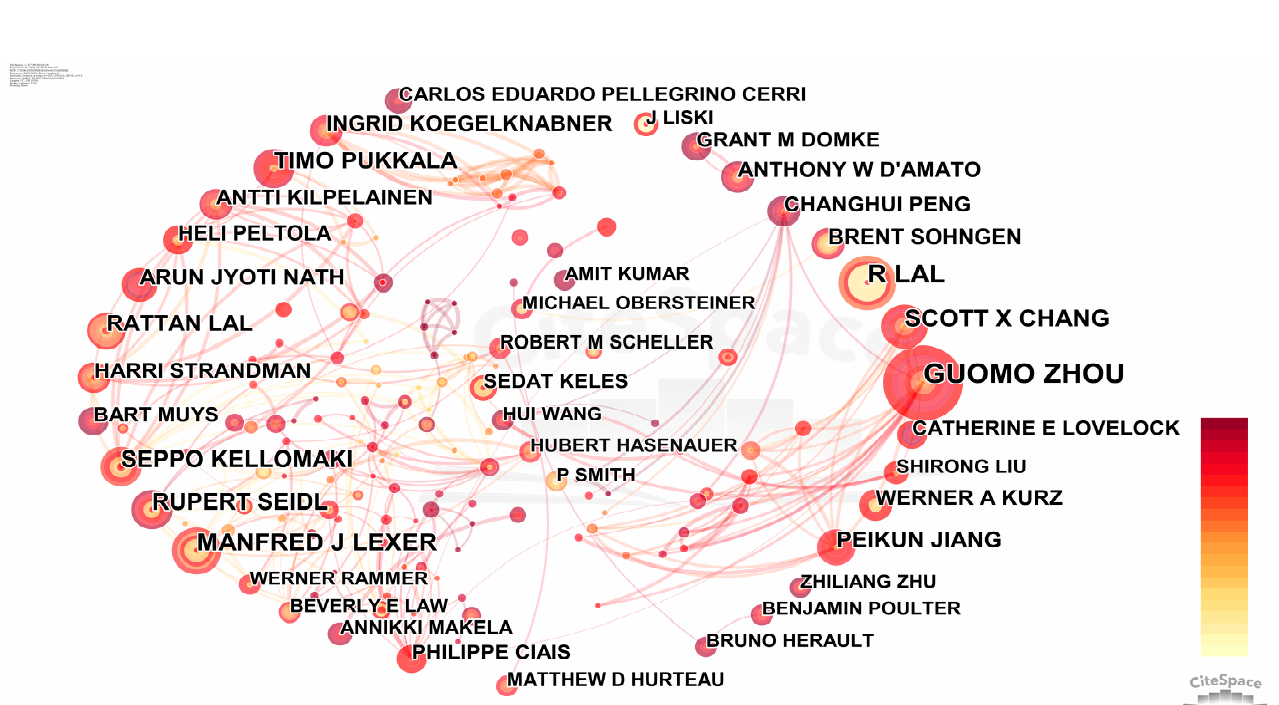
Figure 4. Collaboration-network map of authors. The h-index, known as the h-factor, is a measure of intellectual achievement. The Table 4. Top 10 authors with the highest number of publications and centrality. h-index indicates the academic achievement of a scholar, journal, or country, and the higher the h-index, the greater the influence of the individual’s, journal’s, or country’s papers. Therefore, Table 5 reflects the 20 journals with the highest h-index in this field of study. maintained a high number of publications (559) and had a very high impact (74). Next, Global Change Biology ranked fourth in terms of the number of articles (141) and second in terms of impact (62). The rest of the journals were more even in terms of